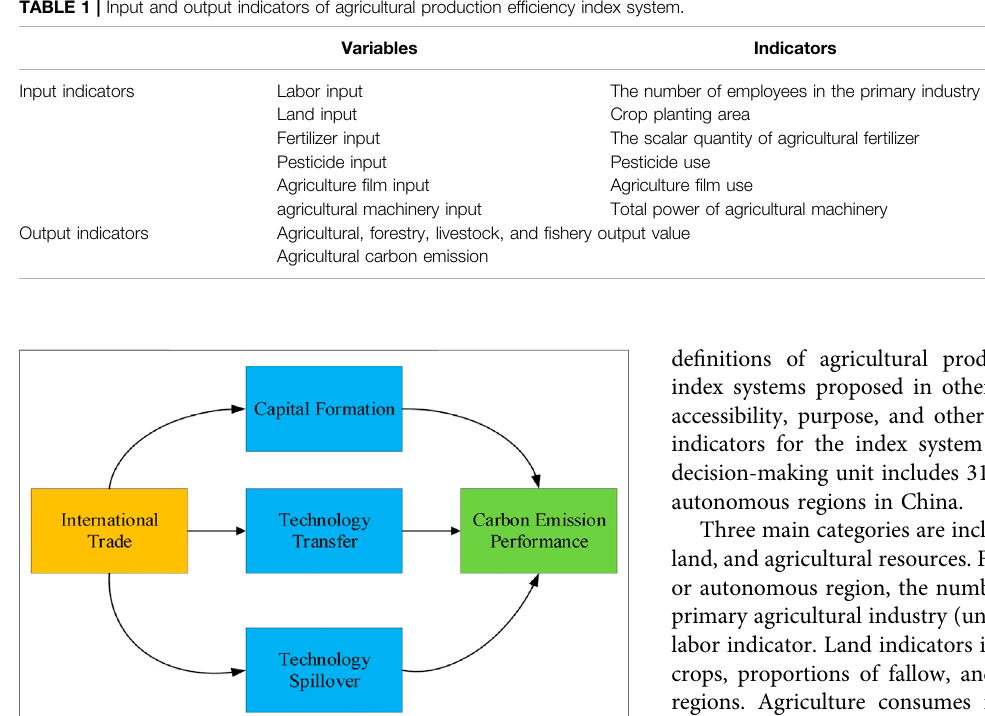
FIGURE 1 | Theoretical framework between international trade and carbon emission